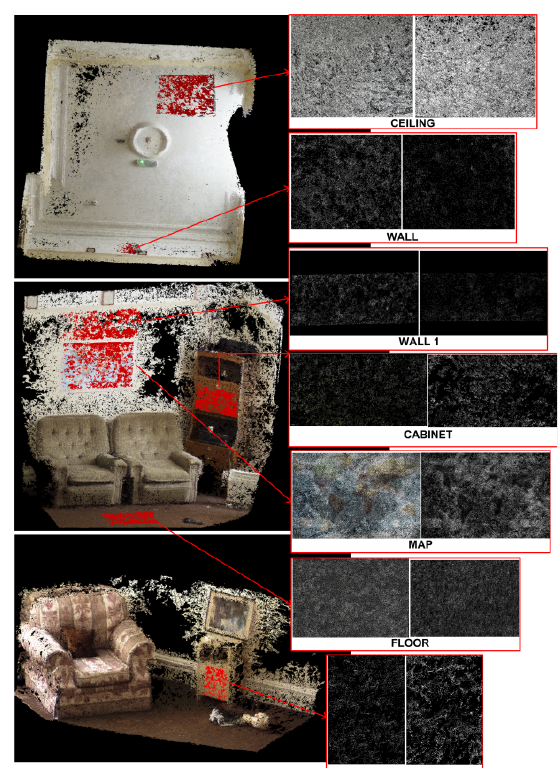
Figure 11. Patches segmented from the point clouds derived from original (left) and pre-processed (right) panoramas.